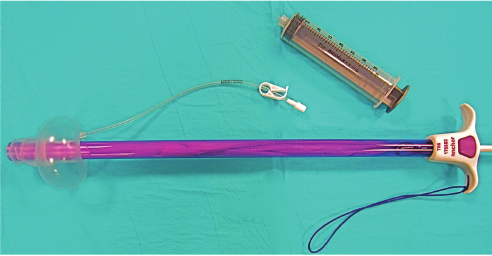
Figure 1: Pneumo-occluder and 15mm anchor device.